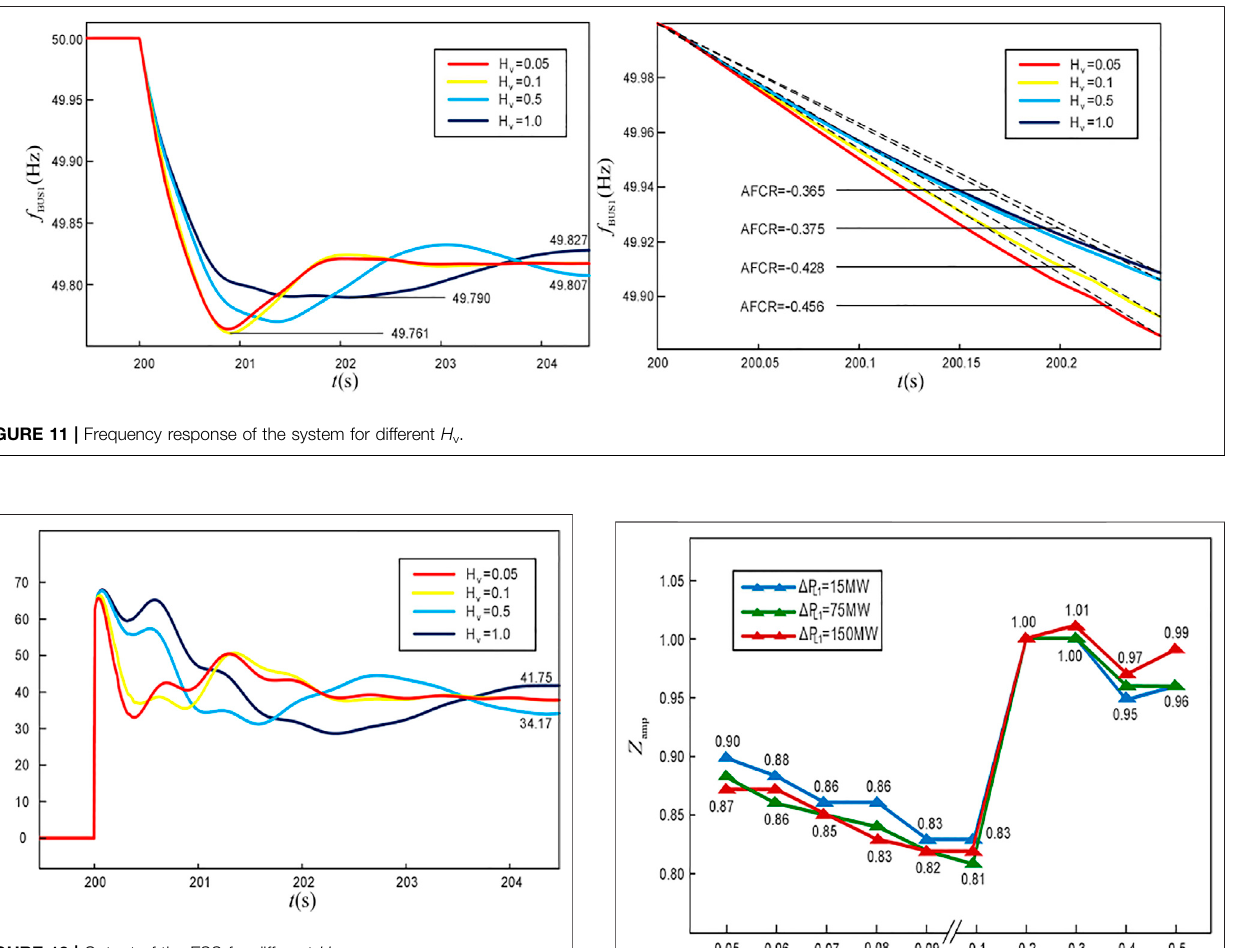
FIGURE 12 | Output of the ESS for different H v .